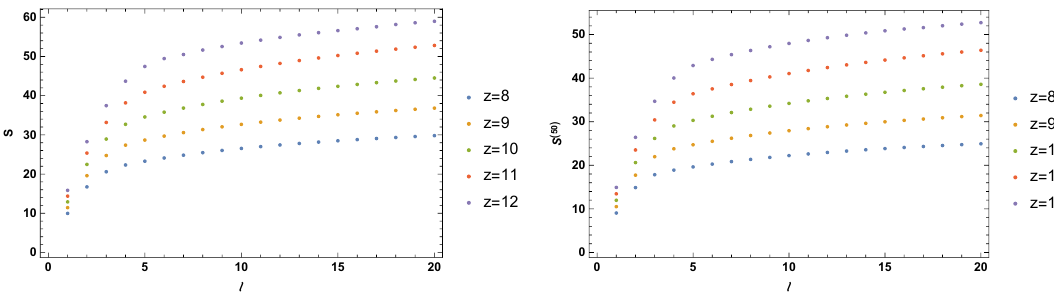
Figure 15 . Entanglement and Renyi entropy for periodic boundary condition in 1 + 1 dimensions with m = 0 : 1 and N =